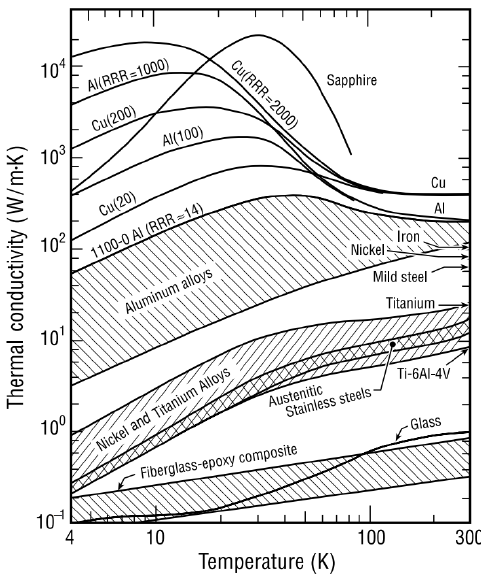
Figure 5. Thermal conductivity of selected classes of materials (ASM 1983)